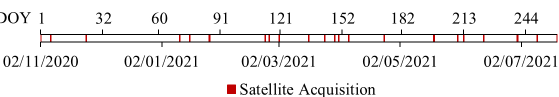
Figure 2 . Acquisition date and DOY (day of the year) of the available S2 L2A